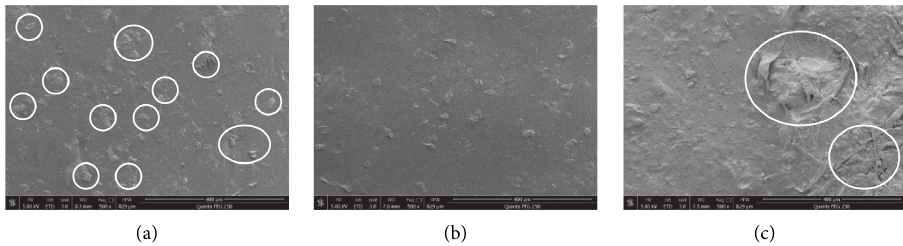
Figure 7: SEM images of AR binders with different CR particle sizes. (a) AR with #40 CR, (b) AR with #60 CR, and (c) AR with #80